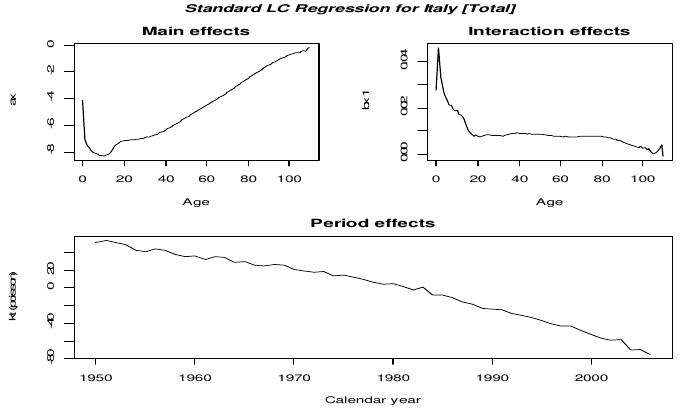
Fig. 1. Poisson Lee-Carter parameters’ model – aggregation by causes of death, Italian total population